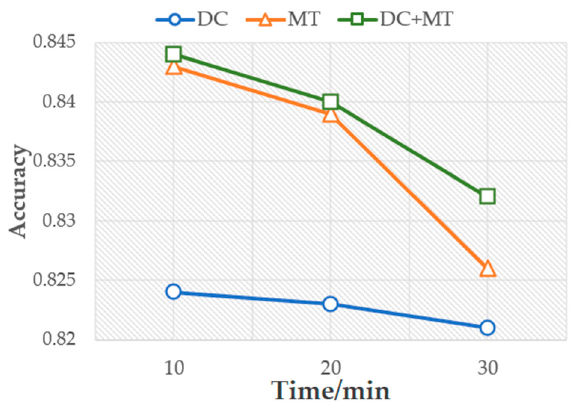
Figure 11. Diagram of the predicted results of the two sub-models.